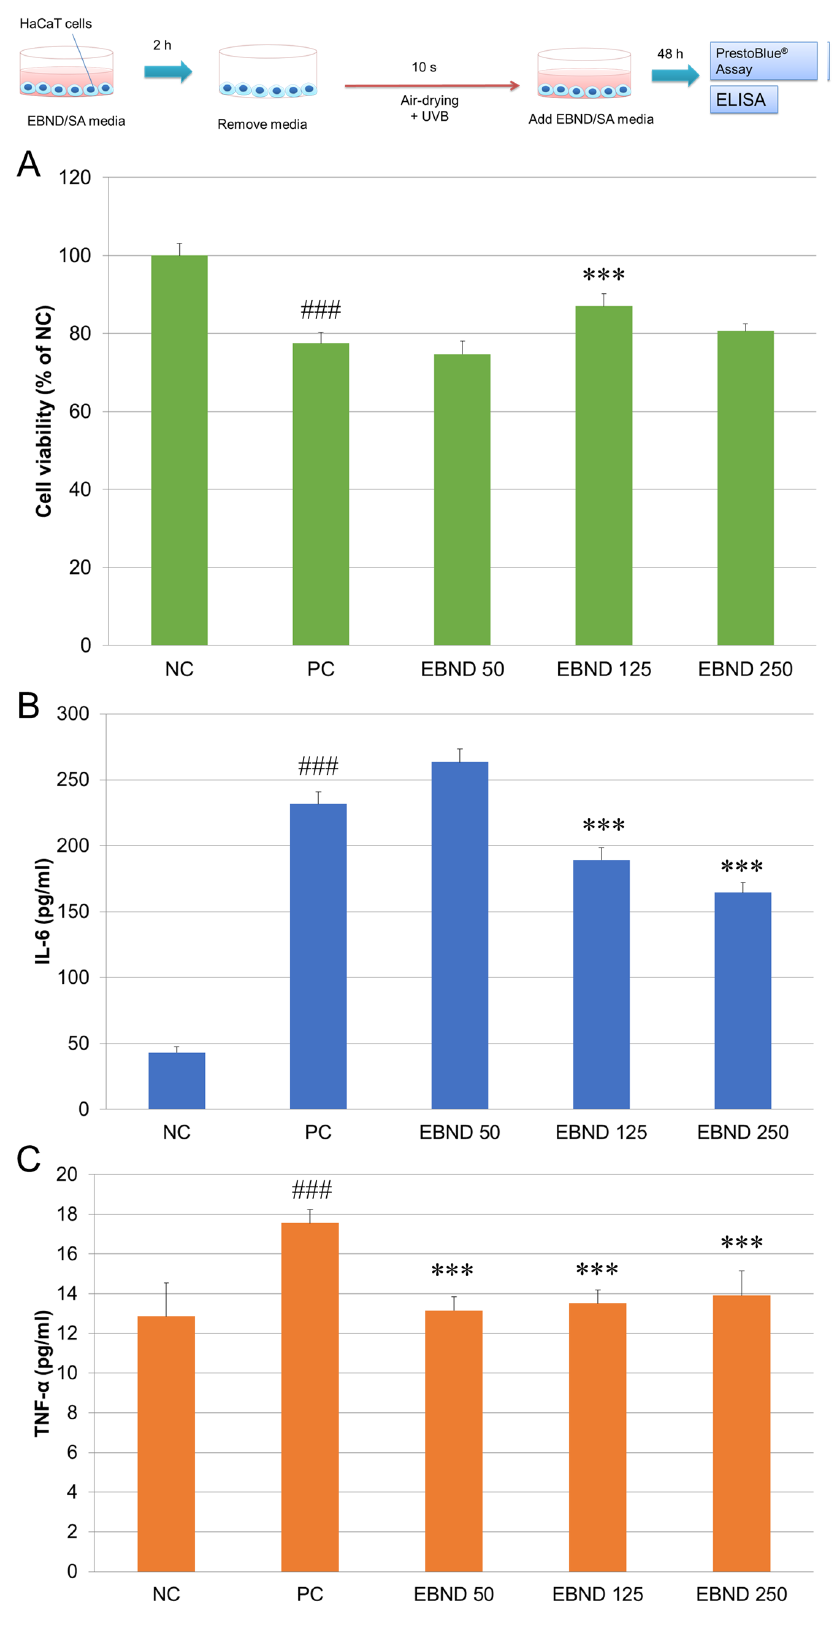
Figure 8. Repressive effects of EBND on UVB-induced cell proliferation suppression and IL-6 and TNF- α secretion in HaCaT cells. The top illustration represents the experimental procedures. At the end of cultivation, cell viability was measured by PrestoBlue assay. Concentrations of IL-6 and TNF- alpha in cell culture supernatant were measured by ELISA as described in Materials and Methods.